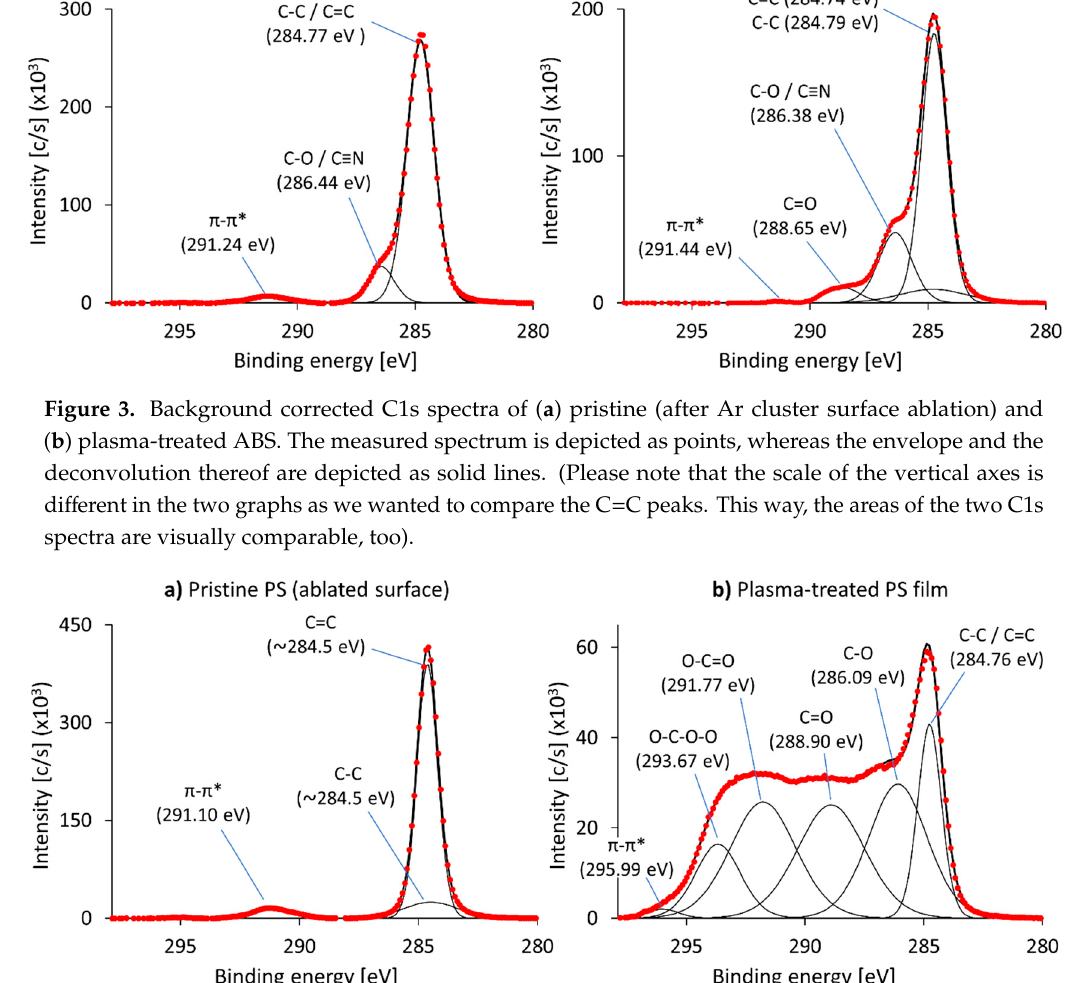
Figure 4. Background corrected C1s spectra of ( a ) pristine (after Ar cluster surface ablation) and ( b ) plasma-treated PS. The measured spectrum is depicted as points, whereas the envelope and the deconvolution thereof are depicted as solid black lines. (Please note that the scale of the vertical axes is different in the two graphs as we wanted to compare the C=C peaks. This way the areas of the two C1s spectra are visually comparable, too.).